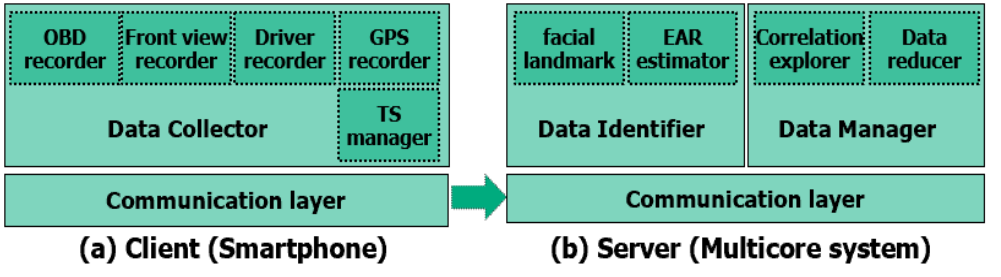
Figure 3. CoDR software